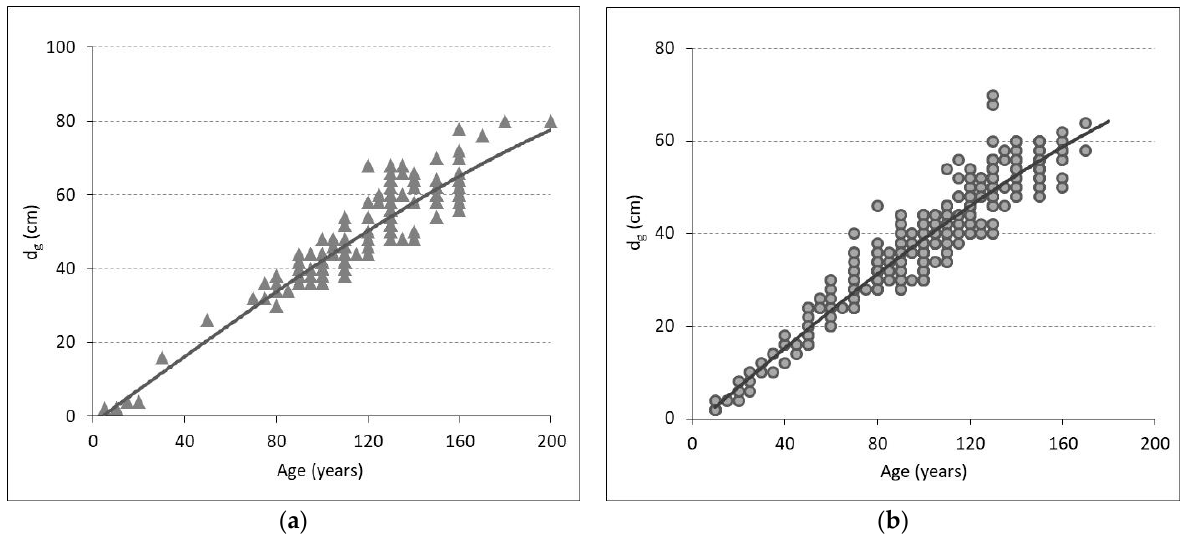
Figure 3. Diameter development, in terms of productivity, in ( a ) silver fir and ( b ) European beech stands .